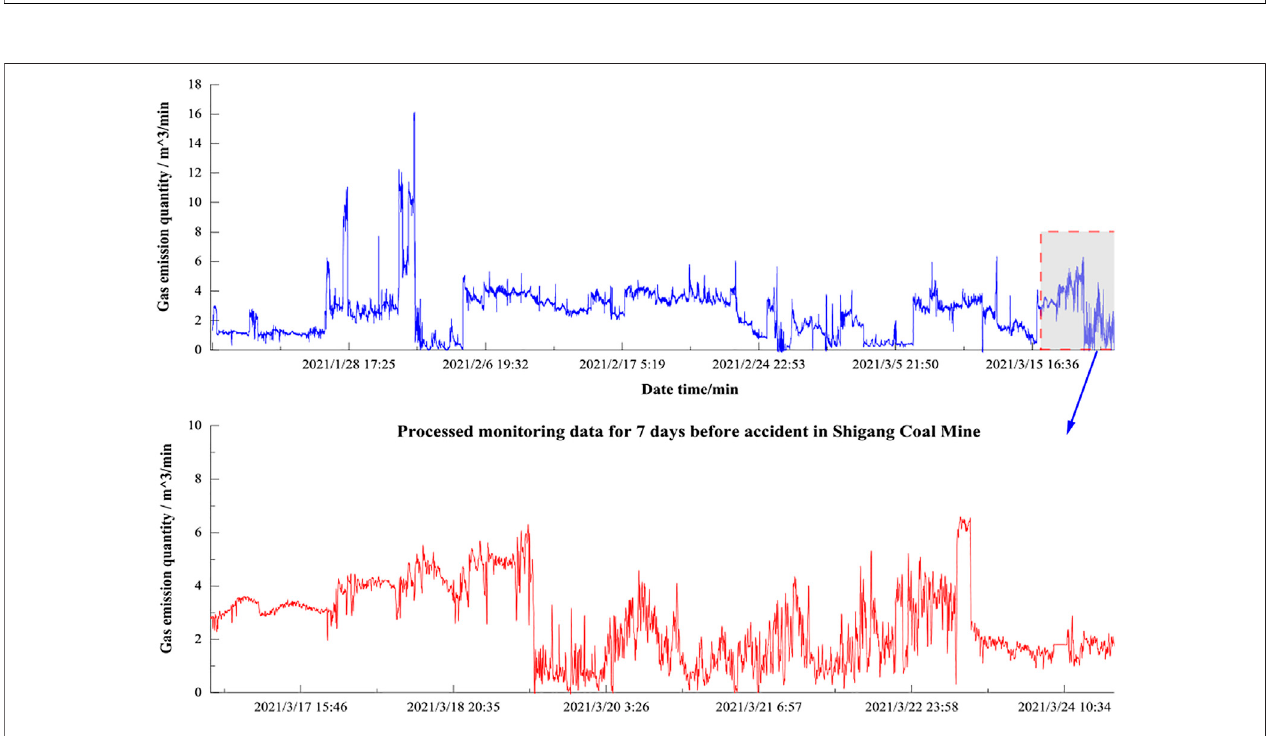
FIGURE 7 | Processed monitoring data in Shigang Coal Mine.